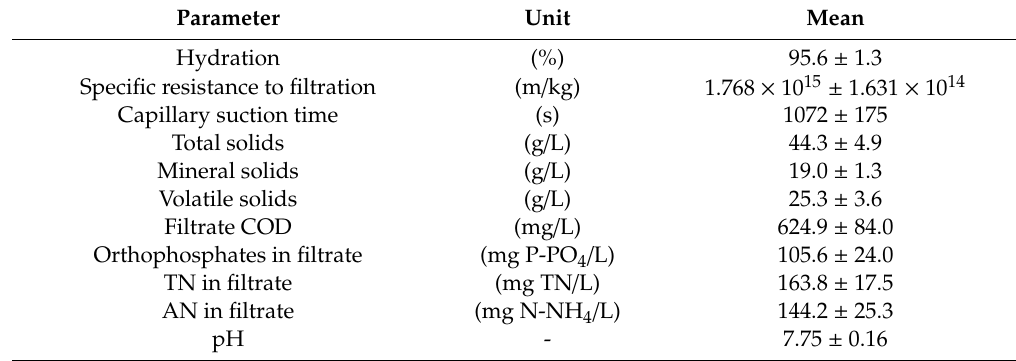
Table 2. Characteristics of the anaerobic inoculum used in the